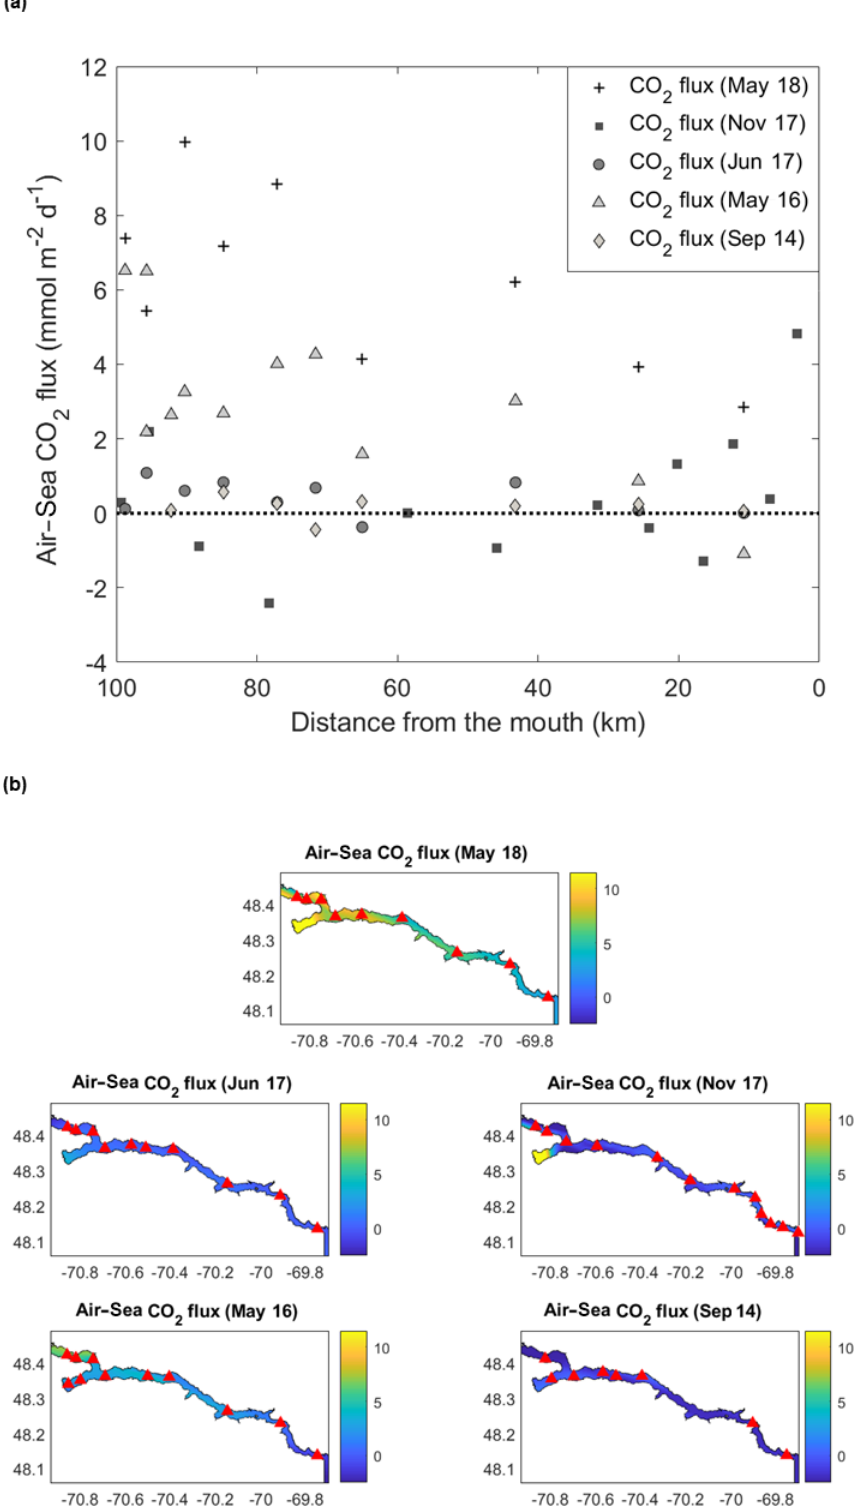
Figure 6. (a) Spatial distribution of air–sea CO 2 flux (mmolm − 2 d − 1 ) in the Saguenay Fjord for all cruises. Data points above the dashed line indicate sources of CO 2 to the atmosphere, whereas those below the dashed line are sinks of atmospheric CO 2 . (b) Spatial interpolation of air–sea CO 2 fluxes (mmolm − 2 d − 1 ) in the Saguenay Fjord for all cruises. Red triangles identify sampling